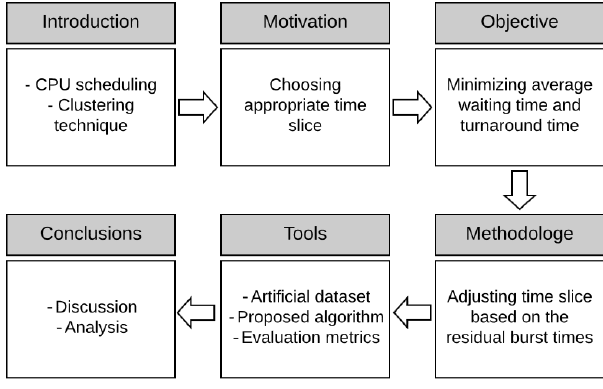
Figure 1. Organization of the paper.